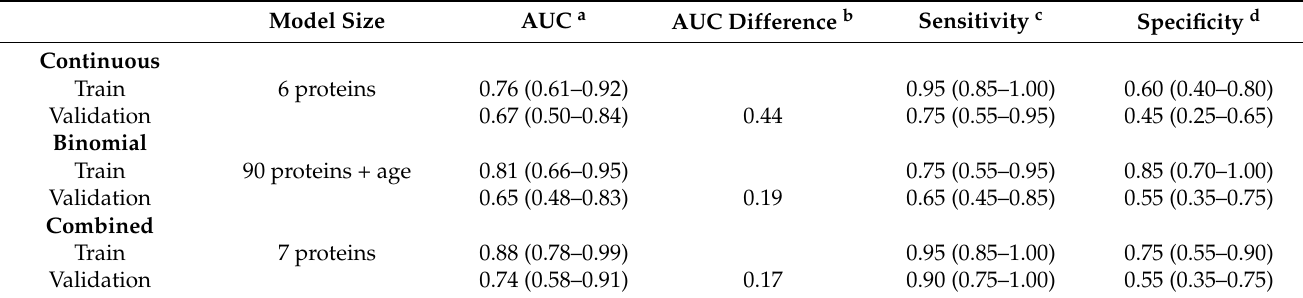
Figure 4. Multivariate analysis performance. ( A ) ROC curve for the training and test proportion of the data (left, 50% of the samples) and for the validation proportion of the data (50% of the samples). The model is based on protein with a continuous distribution of abundance only. The marked point in the left panel curve corresponds to a cut-off representing the best point (closest to perfect classification), and the point estimate of sensitivity and specificity for that cut-off is written out. The red cross on the right panel corresponds to the 95% confidence interval of sensitivity and specificity at the cut-off defined in the training/test set but in the validation set. ( B ) As A, but for the proteins with binomial (i.e., above or below LOD) representation. ( C ) As A, but for a model based on both the proteins with a continuous abundance and those with a binomial representation. Table 2. Performance estimates in the multivariate modelling.